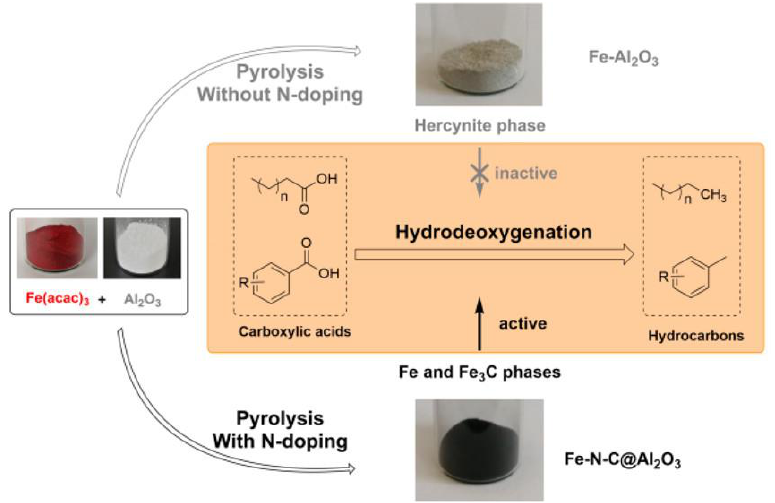
Figure 10. The preparation of Fe-N-C@Al 2 O 3 and its application in the selective hydrodeoxygenation of carboxylic acids. Reprinted with permission from Ref. [79]. Copyright 2019, American Chemical Society.